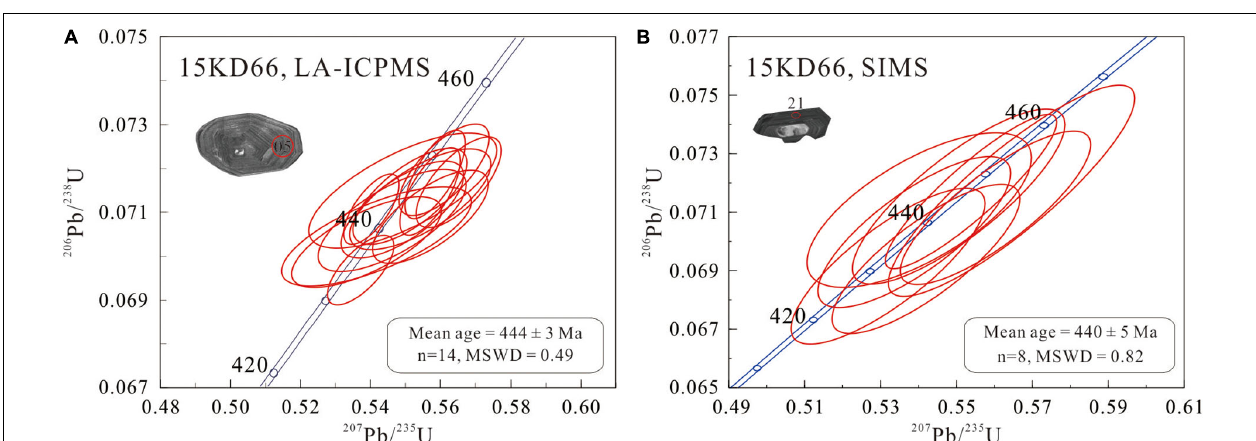
low Th (15–122 ppm, mostly < 35 ppm), and Th/U